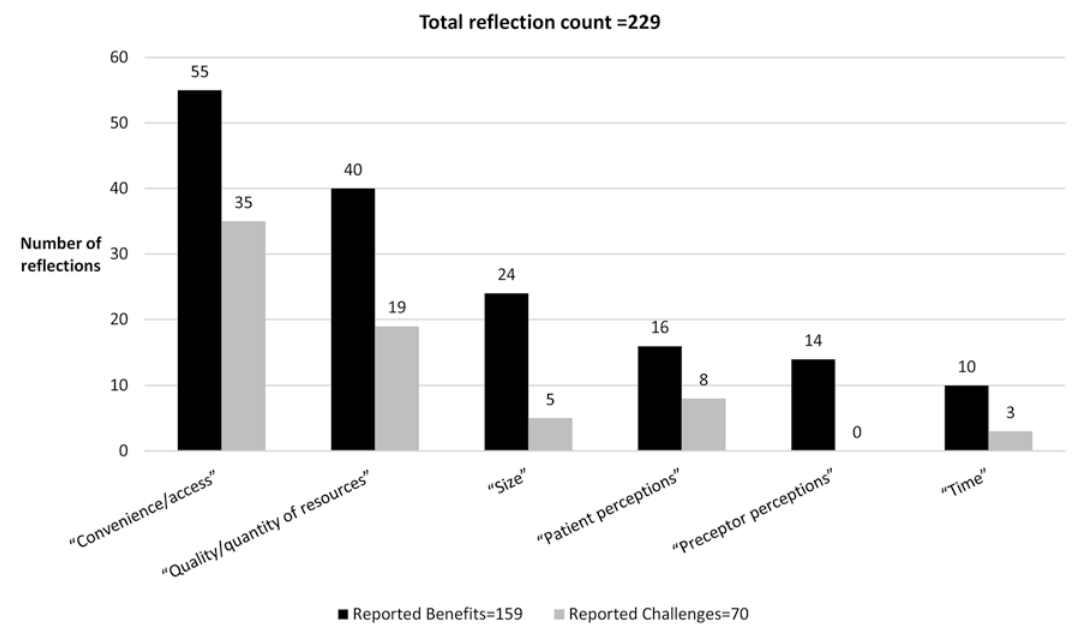
Figure 2 Participant iPad mini use reflections (SLJ reported